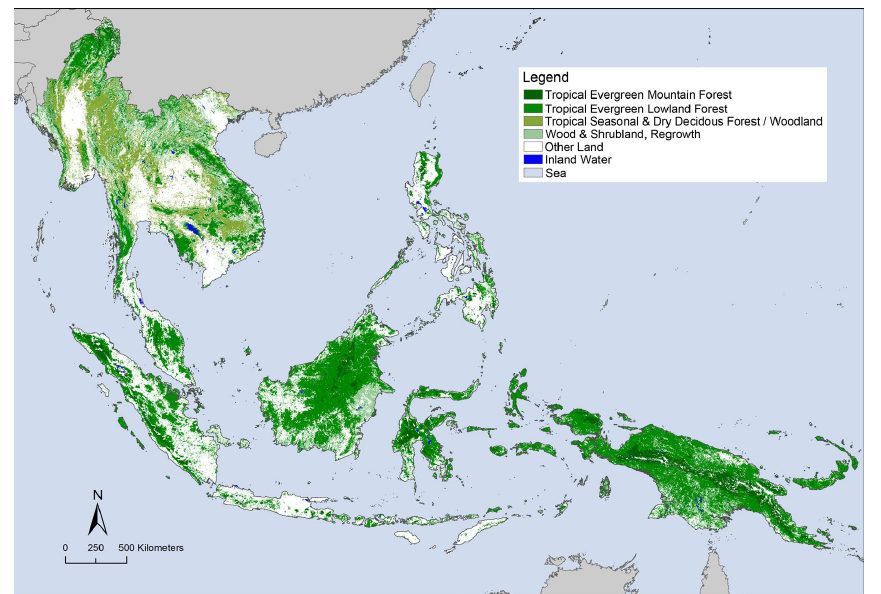
Fig. 1. Regional extent of tropical forest in Southeast Asia (incl. Papua New Guinea) derived from SPOT VEGETATION 1km data of the year 2000 (Stibig et al., 2007a). 4 5